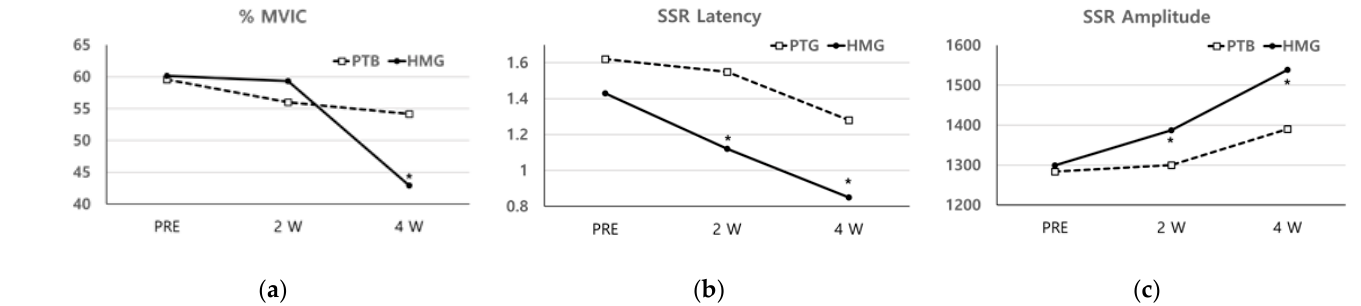
Figure 3. ( a ) The levels of the normalized sEMG signals (%MVIC) were significantly decreased at 4 W in both groups. However, there was a decrease in the HMG compared to the PTG at 4 W ( p < 0.05); ( b , c ) in a comparison between the two groups, the latency, and amplitude of the SSR were significantly different at 2 W and 4 W compared to at PRE ( p < 0.05). (%MVIC: the level of the normalized sEMG signal, SSR: sympathetic skin